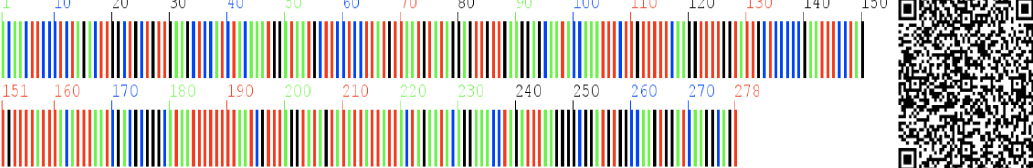
Figure 5. DNA barcoding and two-dimensional DNA barcoding image of psbA-trnH sequences for P. kadsura ( A T C G ).